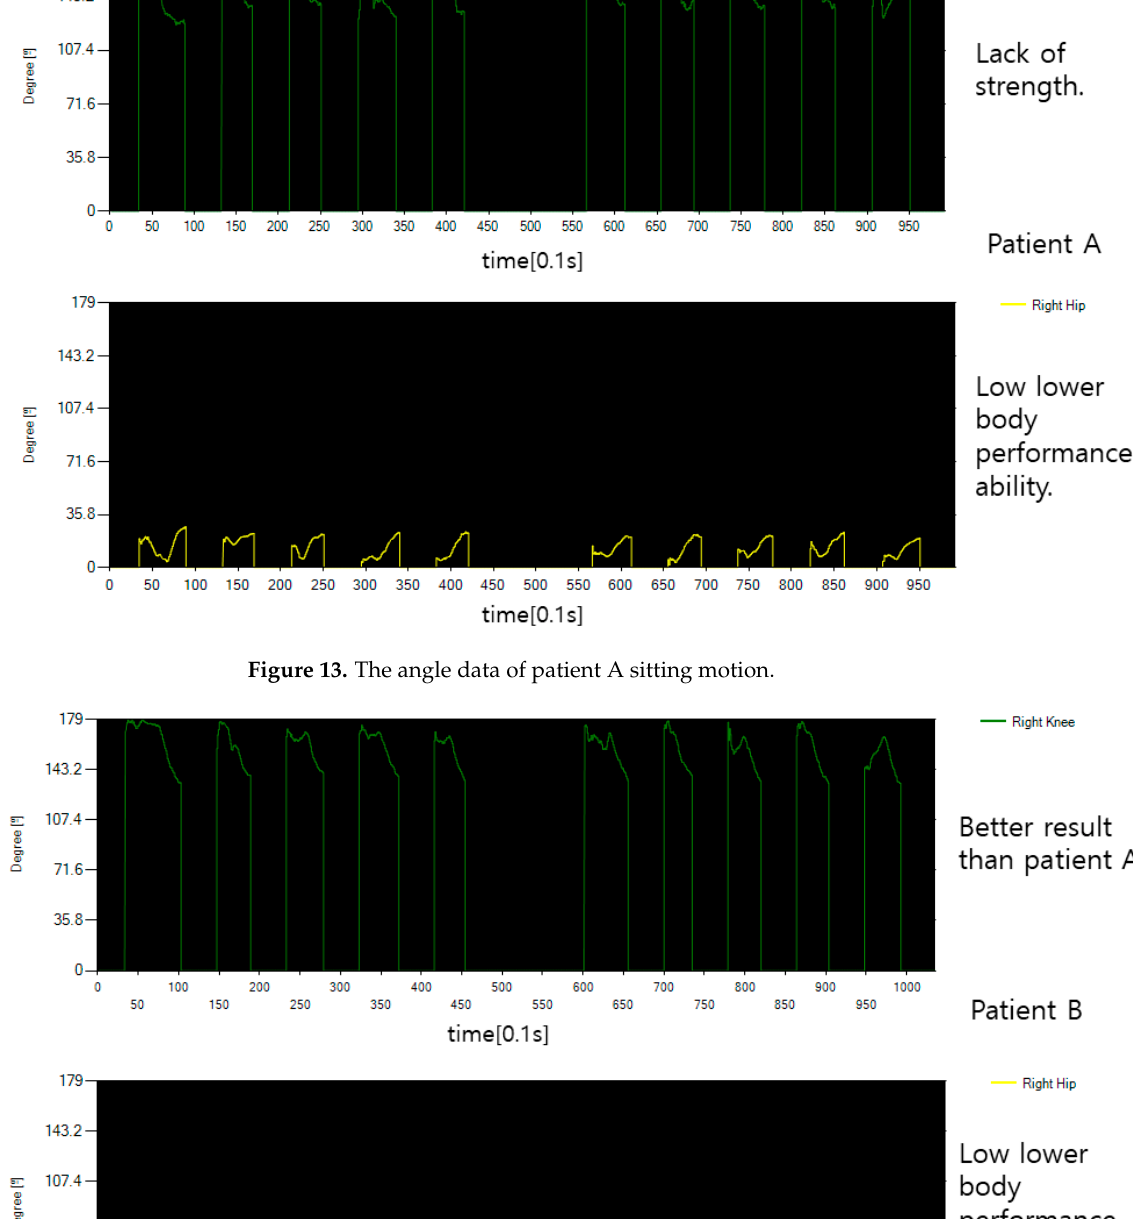
Figure 14. The angle data of patient B’s sitting motion.